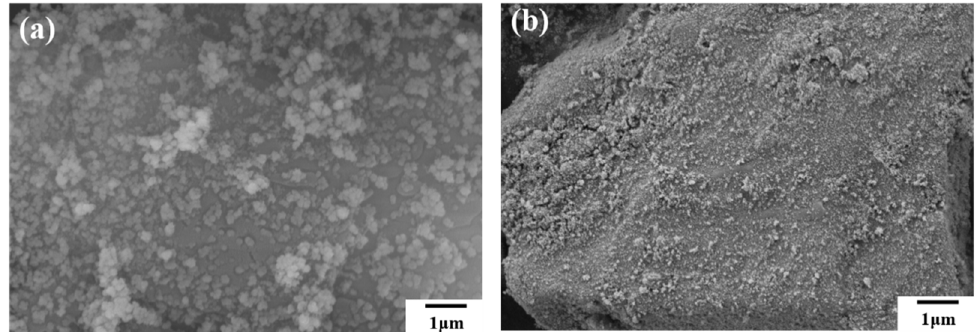
Figure 4. High magnification SEM images of ( a ) NH 4 H 2 PO 4 powder and ( b ) struvite.